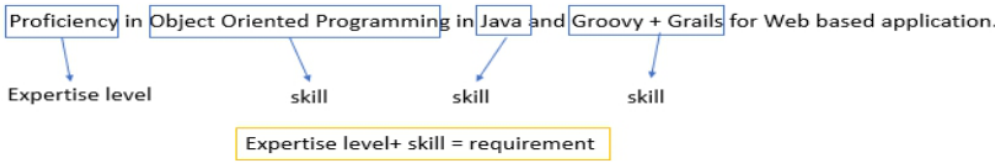
Figure 4. Basic and contextual entities extracted from a job description using